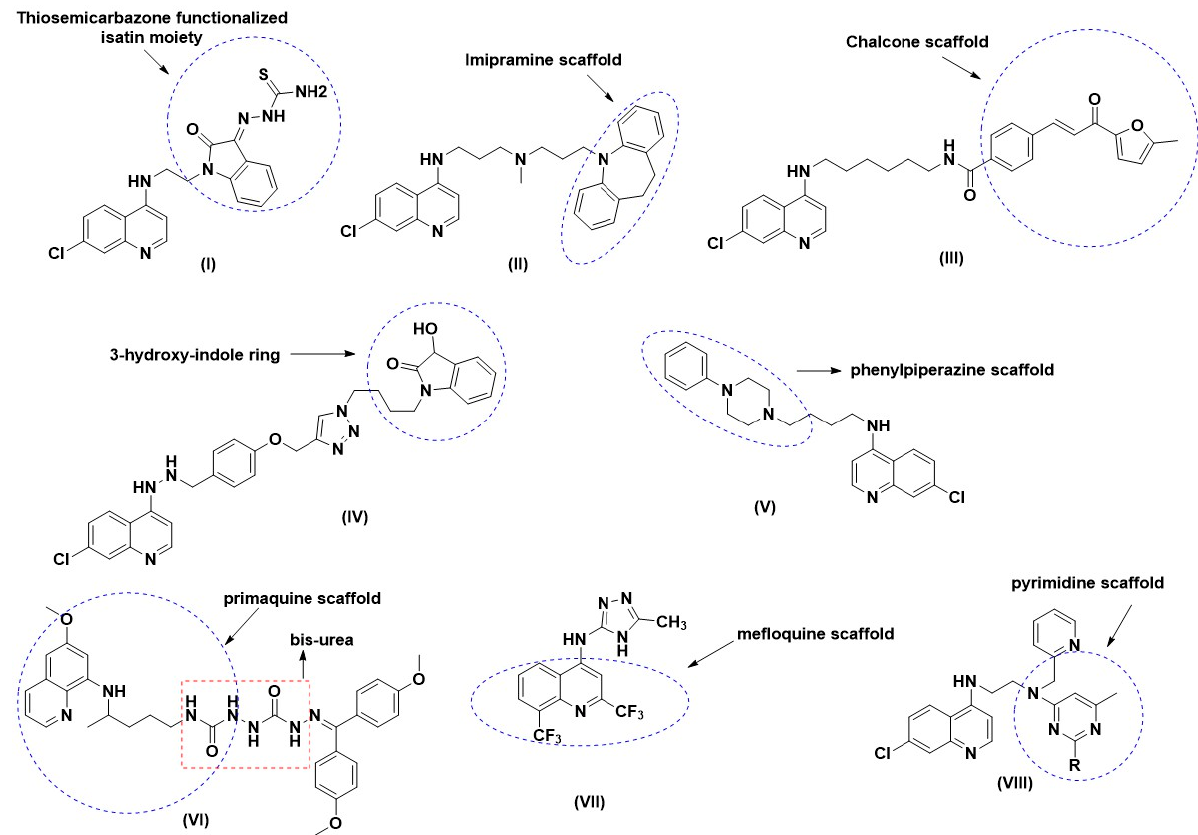
Figure 1. Miscellaneous molecular hybrid based on 4 ‐ aminoquinolines, primaquine, and mefloquine ( I – VIII ) reported from 2005–2019.